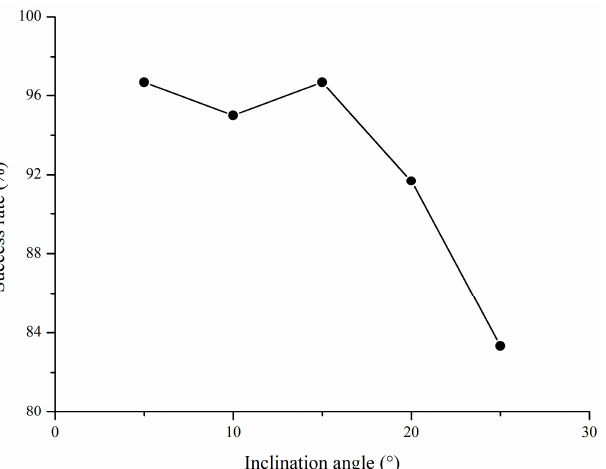
Figure 12. Relationship between inclination angle (IA) and success rate. Note: hole diameter (HD) was 2.5 mm and negative pressure (NP) was 4 kPa.